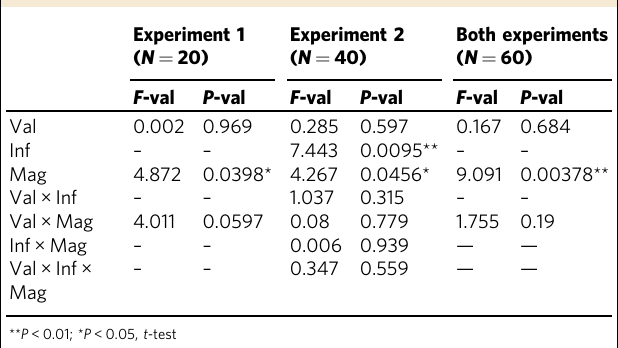
Table 1 Correct choice rate of the learning sessions as a function of task factors in Experiments 1, 2 and both